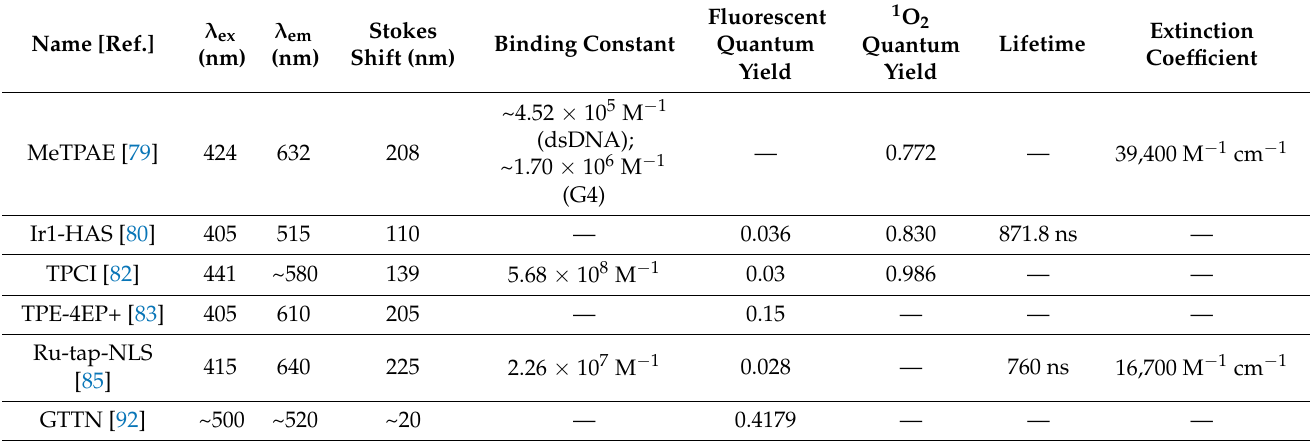
Table 3. Summary of characteristic properties of nucleus-targeted fluorescent probes for